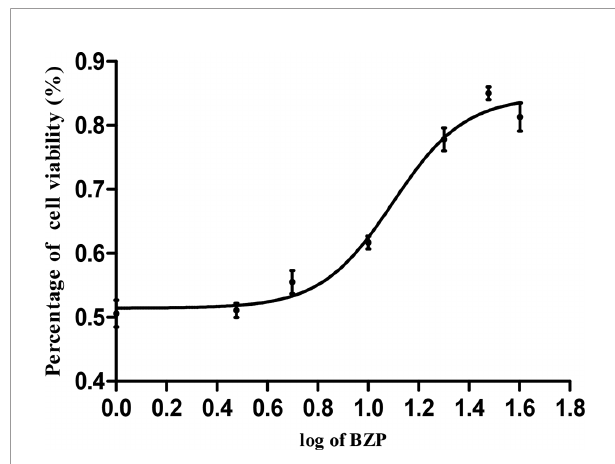
FIGURE 6 | The concentration-response curve of cell viability of PC12 cells induced by OGD/R. PC12 cells were exposed to 30 mmol/L Na 2 S 2 O 4 with low-glucose DMEM for 2 h and then reoxygenation for 24 h, and also pretreated with BZP (5 – 40 m mol/L) for 24 h respectively. X bar represents the concentration of BZP, Y bar represents the inhibition